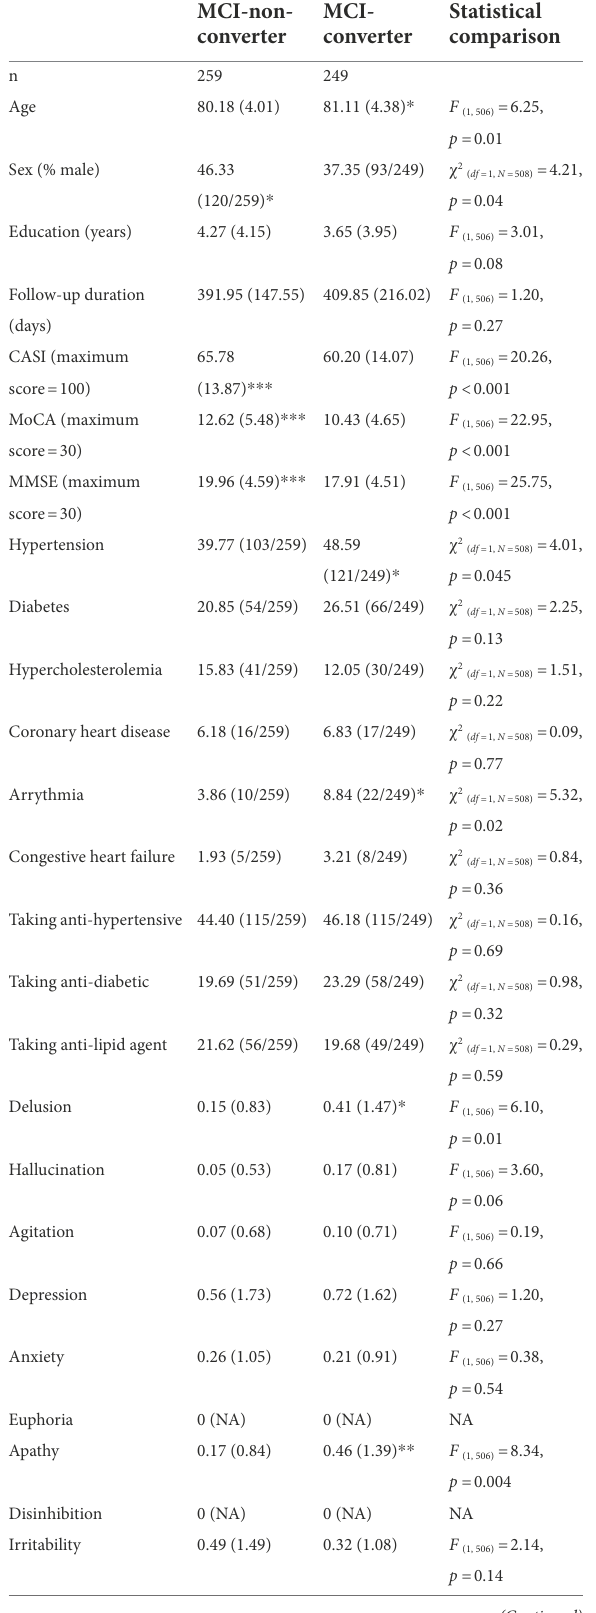
TABLE 2 Demographic and clinical characteristics of patients with MCI over 75 years of